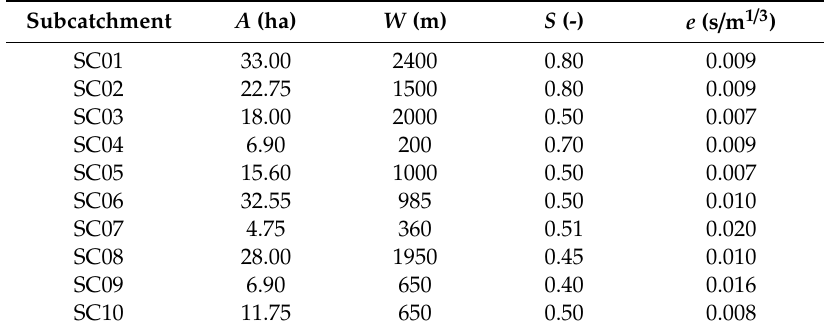
Table 1. SWMM rainfall-runo ff parameters estimated for the 10 subcatchments in Astlingen. Subcatchment A (ha) W